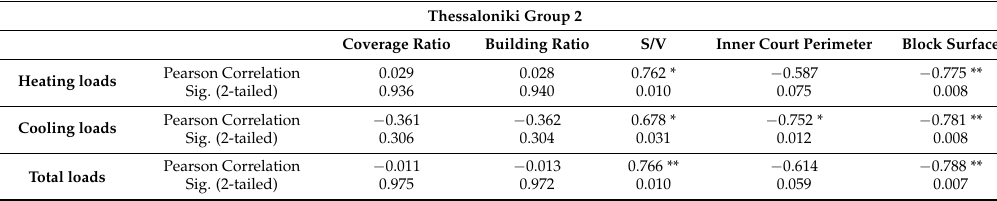
Table 10. Correlation of form parameters to load demand of the urban blocks of group 2 for the climate of Thessaloniki.